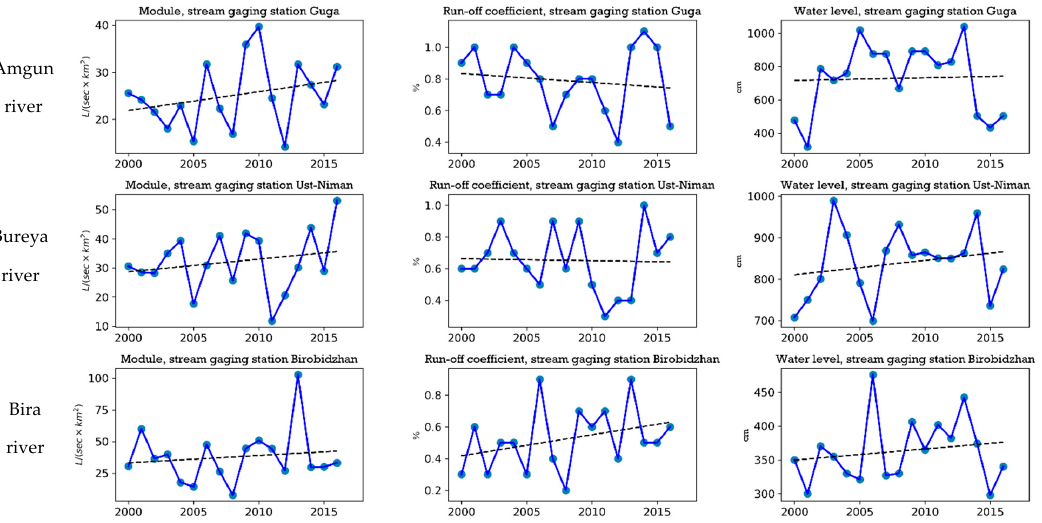
Figure 6. Discharge, run-off coefficient and water level for July–August 2000–2016 on watersheds: Amgun rivers, Bureya rivers, Bira rivers.